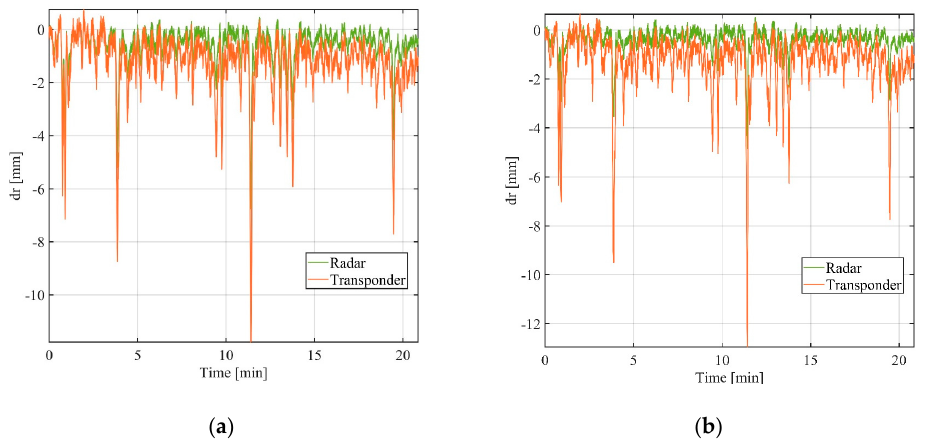
Figure 16. Displacement measured by the radar and the transponder for target at y = 85.9 m ( a ) and at y = 99 m ( b ).